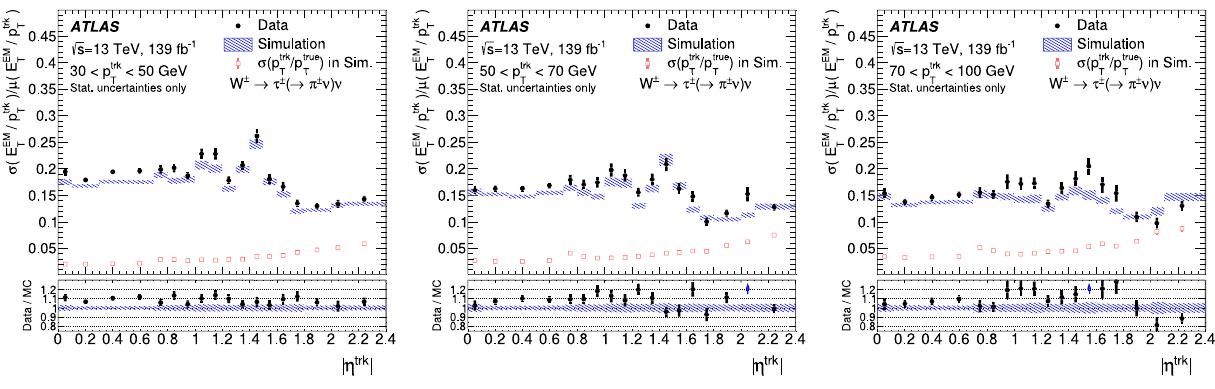
/ p trk Fig. 9 The fitted width divided by the mean of the signal E EM p T for true τ → π ± ν τ events in simulation to give an illustration of T T the contribution to the total width from the resolution of reconstructed distribution as a function of the track | η | in three p trk ranges: 30 < T tracks. The uncertainties shown are only those from the limited number < 50 GeV, 50 < p trk < 70 GeV and 70 < p trk < 100 GeV. Also p trk T T T of events in the dataset and simulated shown is the fitted width of the track p T divided by the generator-level